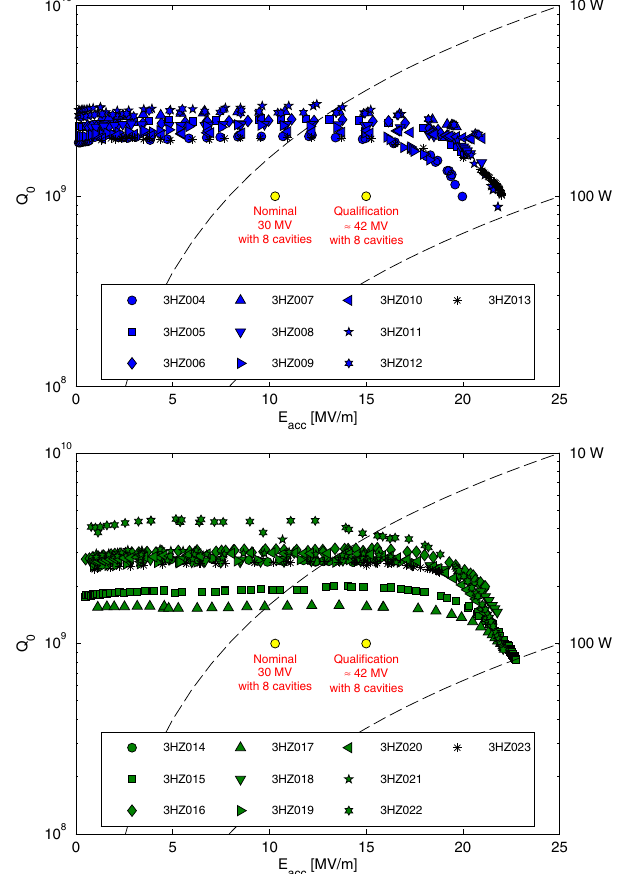
FIG. 10. Summary plots for power rises of the two batches of the EXFEL 3.9 GHz cavities at 2 K. First batch (top): cavity serial numbers from 3HZ004 to 3HZ013, second batch (bottom): cavity serial numbers from 3HZ014 to